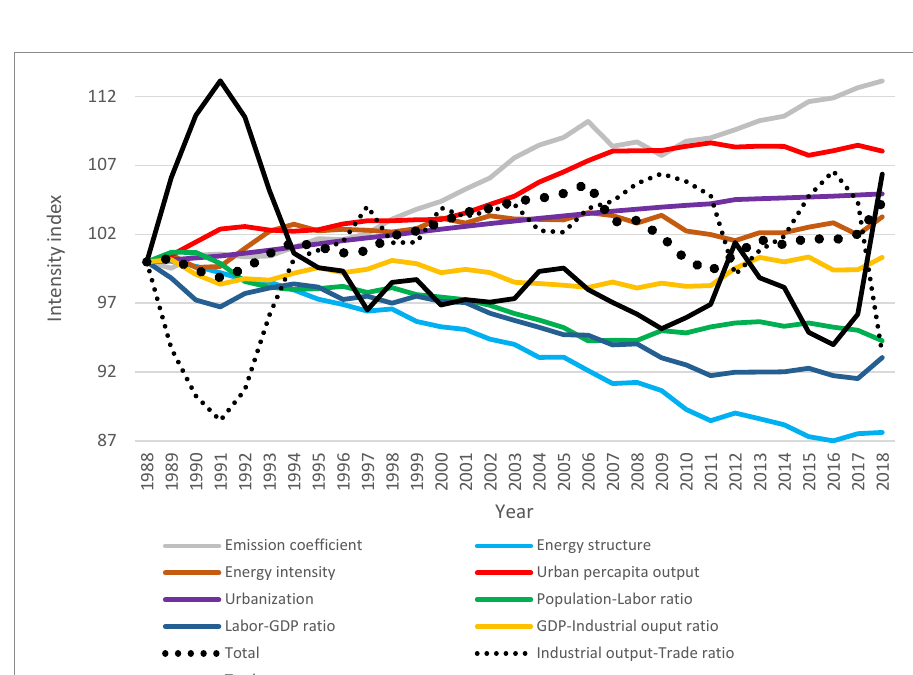
Fig. 8: CO emission intensity and its components